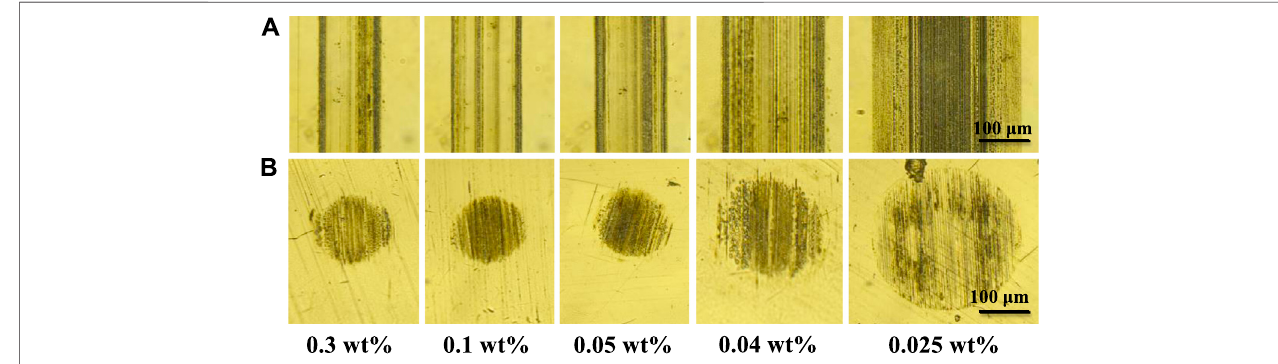
Frontiers in Chemistry |